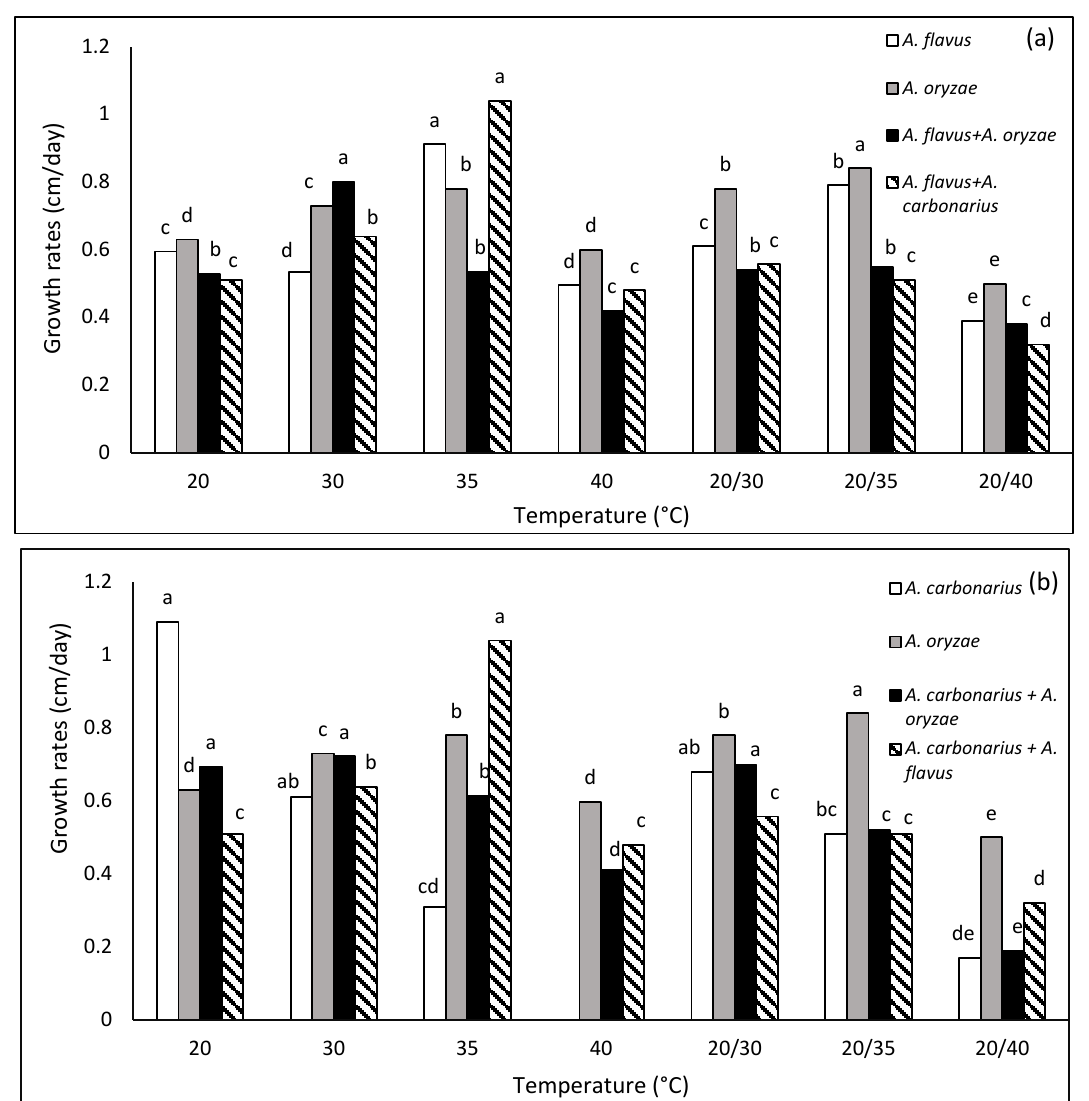
Figure 1. Growth rates, µ (cm/day), of ( a ) single culture and mixed cultures of A. flavus, ( b ) single culture and mixed cultures of A. carbonarius at static and fluctuating temperatures on CCA for 6 days. The letters (a, b, c, d, and e) indicate significant differences at p -value < 0.05 among 7 temperature levels on the same culture.